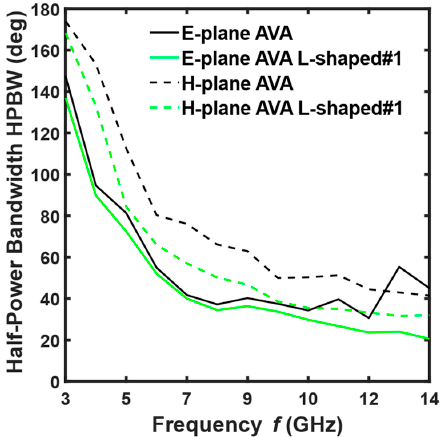
Figure 15. Measured E-plane (solid curve) and H-plane (dashed curve) half-power bandwidth of AVA (black curve) and AVA L-shaped#1 (green curve) as a function of frequency.